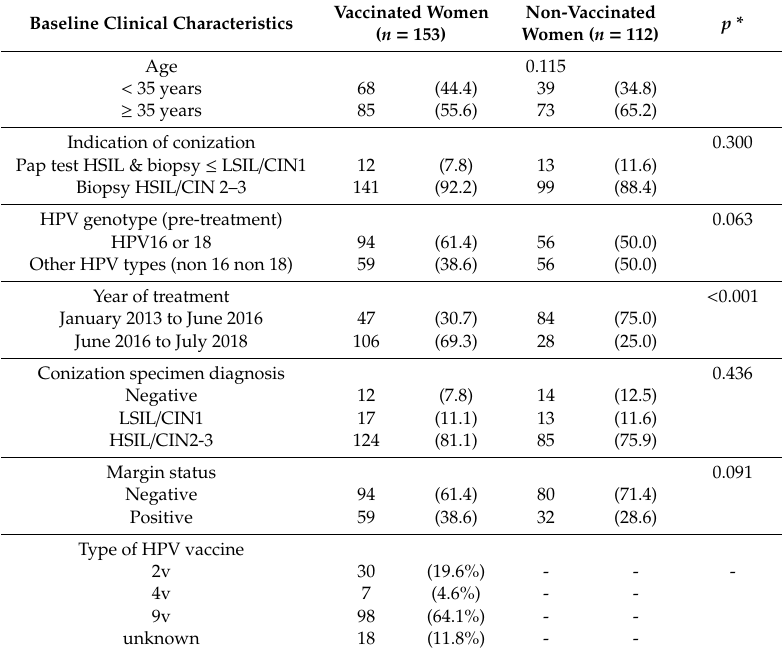
Table 1. Baseline clinical characteristics and results of the conization specimen in women who were vaccinated and those who refused the HPV vaccine. Values are absolute numbers and